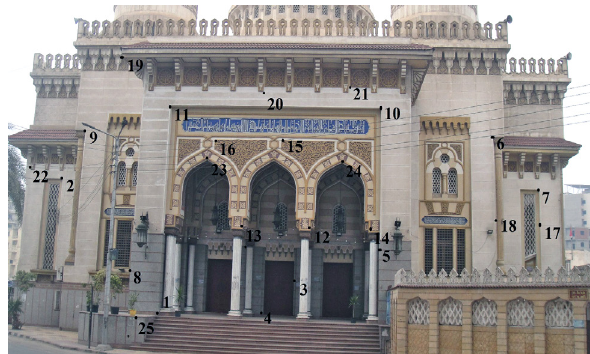
Figure 5. The distribution of observed points on El-Nasr Mosque façade